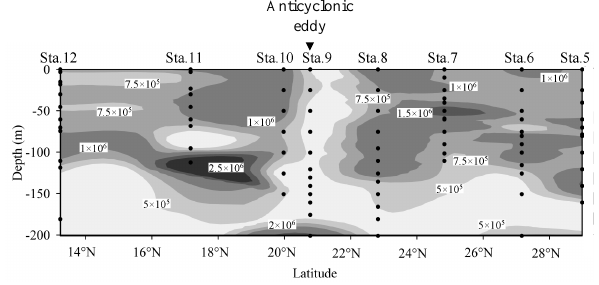
Fig. 11. Vertical concentration (cellscm − 3 ) of the heterotrophic prokaryotes between stations 5 and 12. The black dots are the sam- pled depths.